Question: What visual encoding does this figure use to show its data?
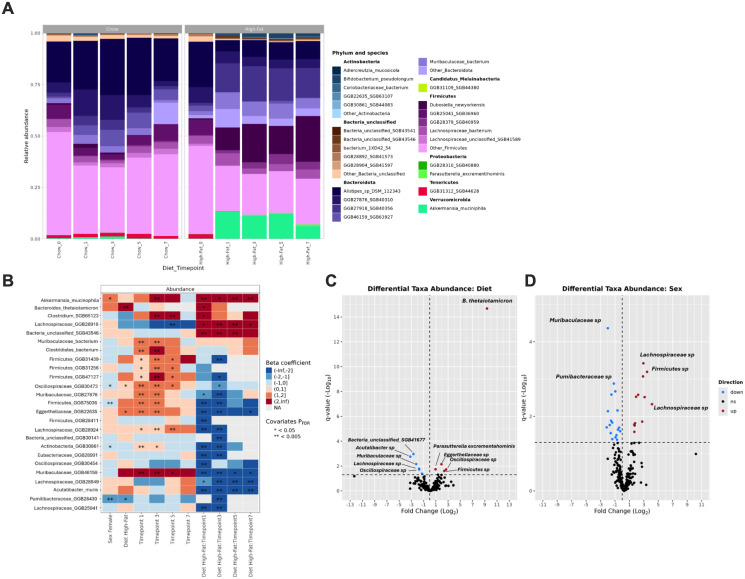
Answer: heatmap